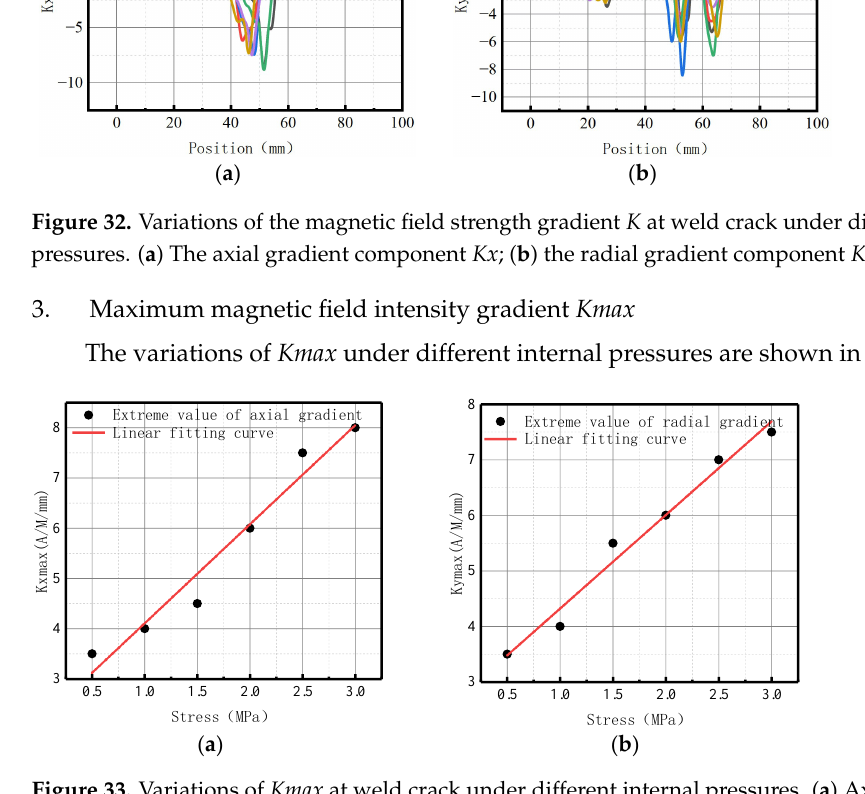
Figure 33. Variations of Kmax at weld crack under different internal pressures. ( a ) Axial component of Kmax ; ( b ) radial component of Kmax .